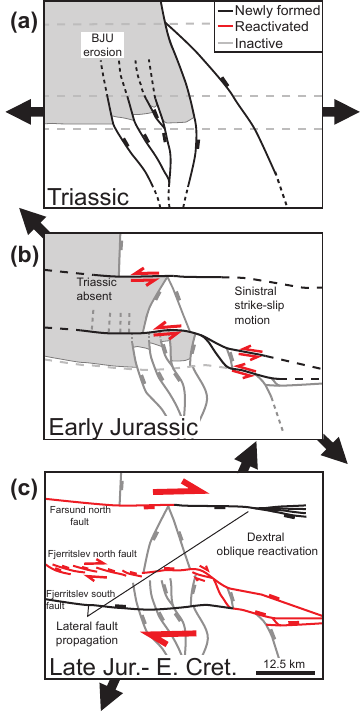
Figure 15. Schematic model showing the fault geometries and kine- matics during (a) Triassic E–W extension; (b) Early–Middle Juras- sic sinistral strike-slip activity; and (c) Early Cretaceous dextral